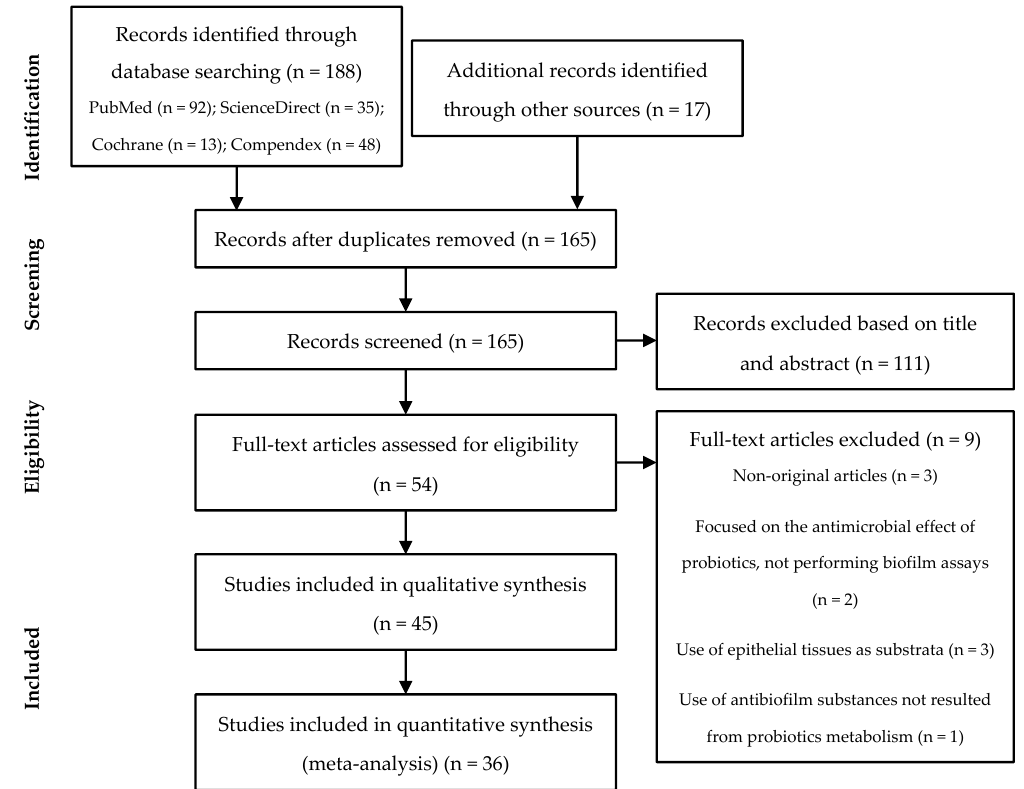
Figure 2. Preferred Reporting Items for Systematic reviews and Meta-Analyses (PRISMA) flow-chart.